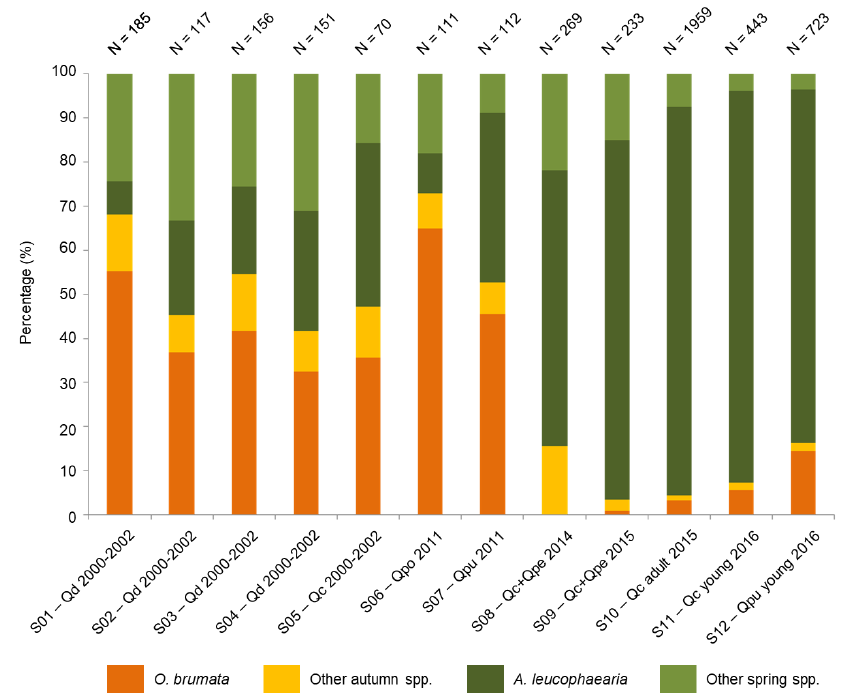
Figure 2. Composition of caterpillar assemblages consisted of winter moth species on oaks in various areas in Slovakia. S01 – S12: sample number (for details, see Table 1); Qd, Quercus dalechampii ; Qc, Q. cerris ; Qpe, Q. petraea ; Qpo, Q. polycarpa ; Qpu, Q. pubescens . Forests 2020 , 11 , x FOR PEER REVIEW